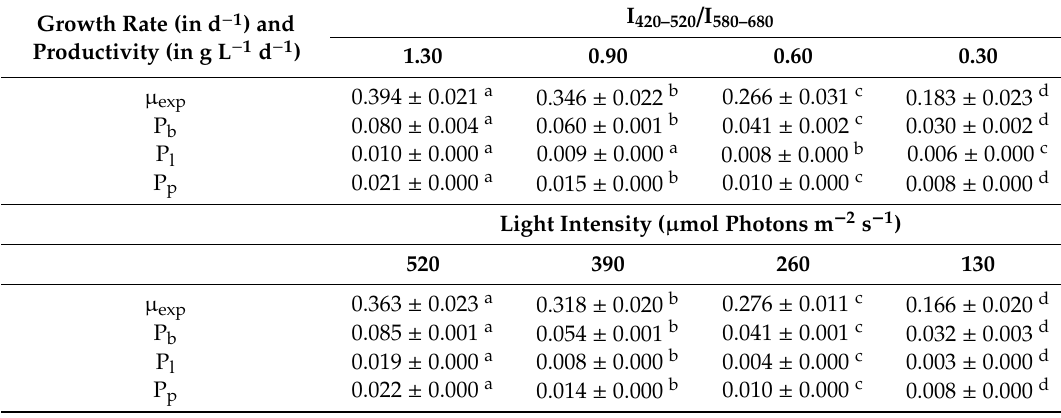
Values represent averages ± std. deviation ( n = 3). Values in the same row followed by different superscript indicate statistically significant difference ( p < 0.05). Table 4. Composition (%) of C. vulgaris cultivated at four different ratios (I 420–520 /I 580–680 ) and at four different light intensities with white and red LED lamps in the closed bioreactor (in μ mol photons m − 2 s − 1 ).